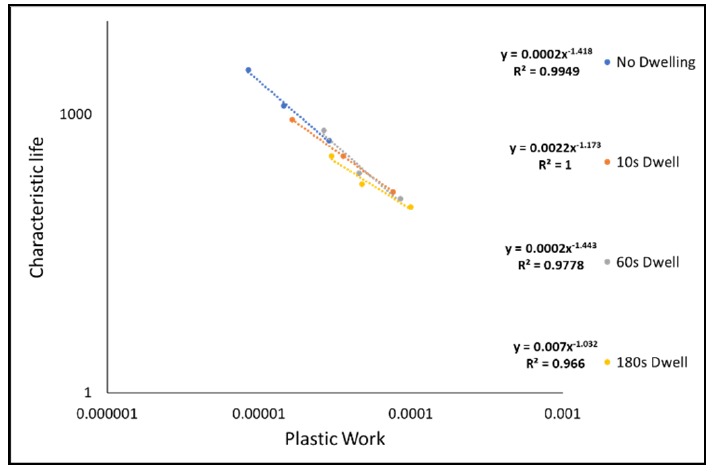
Figure 32. Characteristic life vs. inelastic work for SAC305 joints at various dwelling times on a log–log scale. Table 3. Fatigue ductility coefficient and fatigue exponent of the Morrow Energy model.